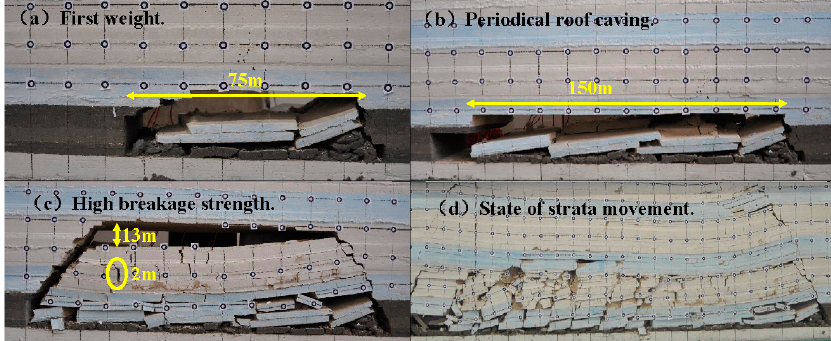
Figure 8. Fracture characteristics of strata without mining the No. 4 coal seam.